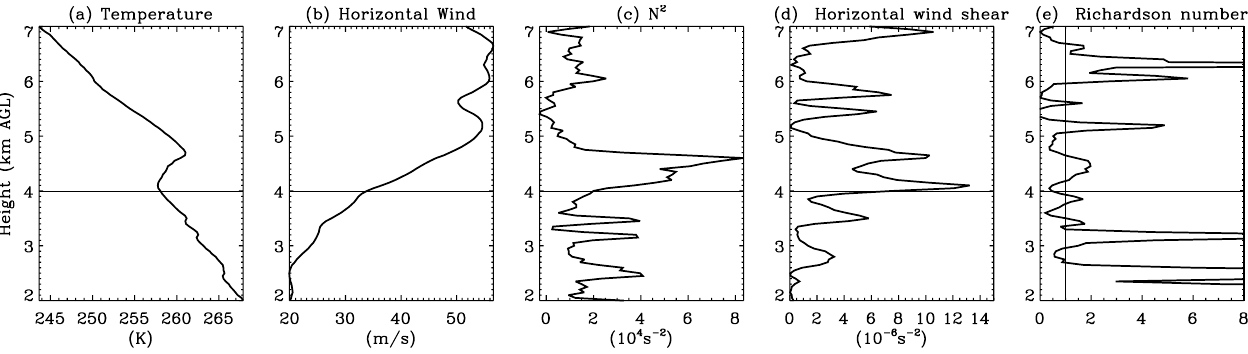
Fig. 3. Profiles of (a) temperature, (b) horizontal wind, (c) buoyancy frequency square ( N 2 ) , (d) horizontal wind shear and (e) Richardson number over Brookhaven (40.9 ◦ N, 72.9 ◦ W) at 12:00UT on 15 November 2003. The horizontal lines denote the reference height of LTI. The vertical line in (e) denotes Ri =